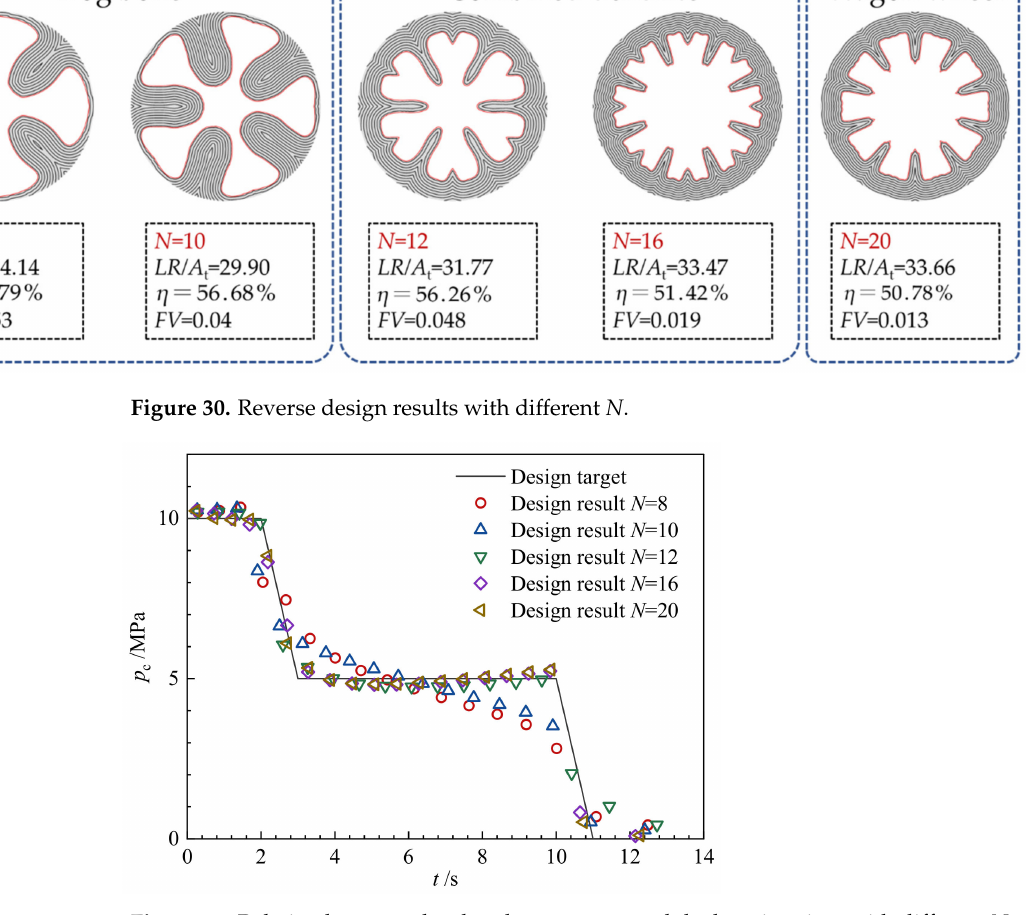
Figure 31. Relation between the chamber pressure and the burning time with different N